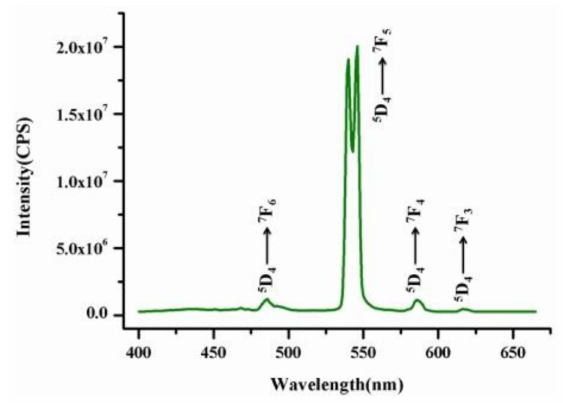
Figure 9. Solid state fluorescence emission spectra of complex 1 at room